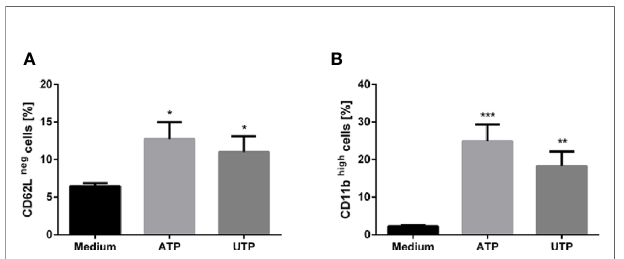
FIGURE 1 | The effect of extracellular ATP and UTP on the cell surface expression of CD62L and CD11b on neutrophils. Primary human neutrophils were incubated for 30 in the presence of ATP (500 µM) or UTP (100 µM). The expression of CD62L (A) and CD11b (B) was assessed by using fl ow cytometry. Bar diagrams show % ± SD (n=3). *p < 0.05, **p < 0.01, ***p <